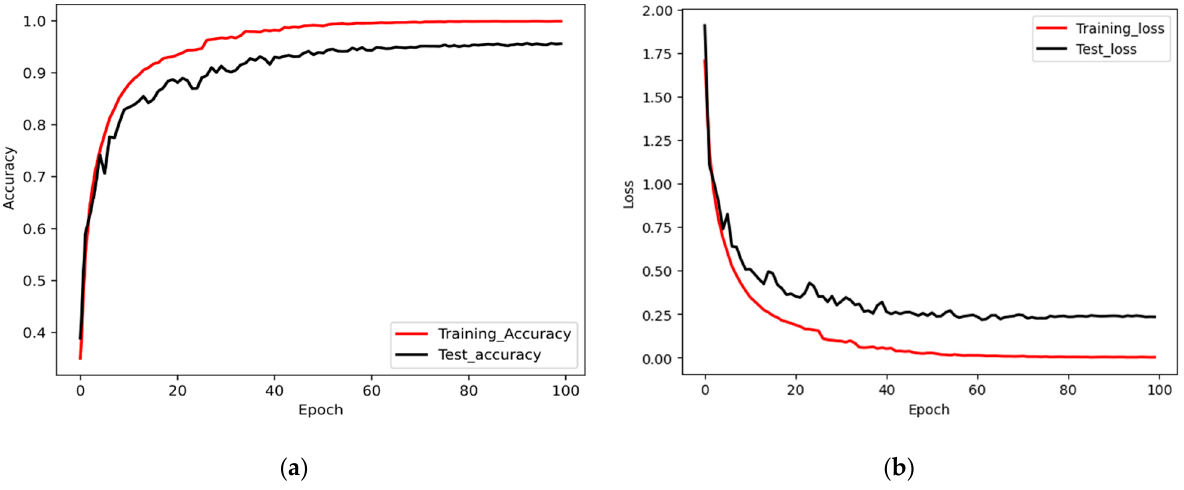
Figure 5. ( a ) Accuracy graph for training and testing; ( b ) Loss graph of the proposed method for training and testing.